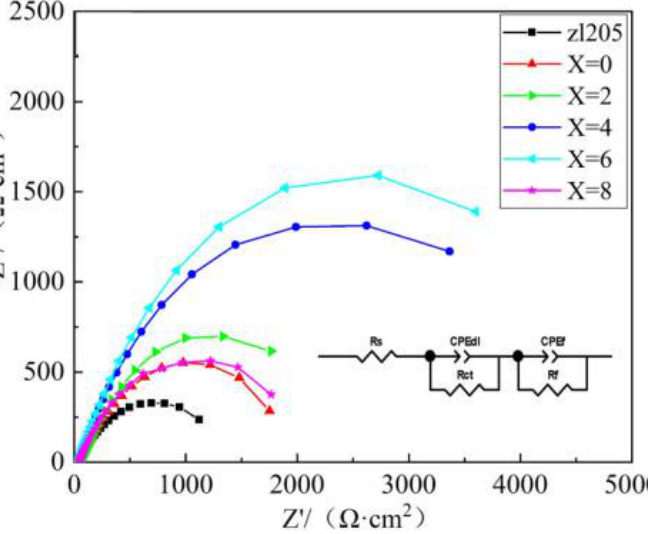
Figure 9. Nyquist diagram of the ZL205 alloy after the addition of the Al-TiO 2 -C-XEr 2 O 3 refiner.